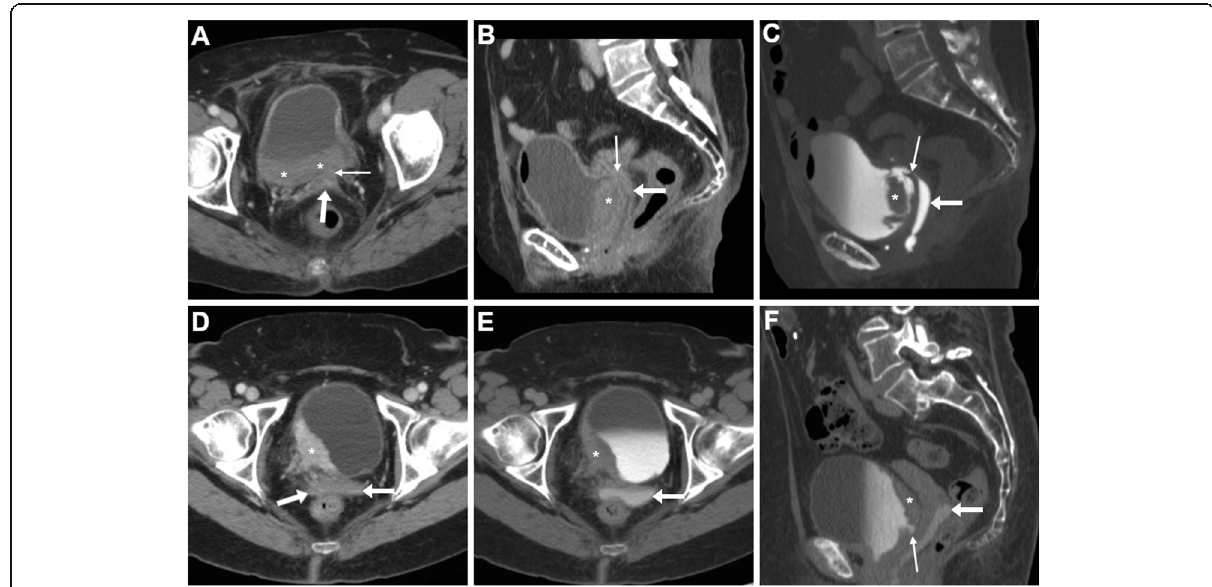
Fig. 16 Two cases of urinary VF complicating bladder cancers. a – c In a patient with previous hysterectomy, CT ( a , b ) shows extensive mural thickening (*) of the posterior bladder aspect, causing adhesion and focal retraction of the bladder dome, and corresponding filling defect on excretory phase acquisition ( c ). The patent VF (thin arrows) leads to opacification of the vagina (arrows). d – f In a patient with strongly enhancing tumour (*) of the right posterolateral aspect of urinary bladder ( d ), excretory phase acquisition ( e , f ) shows vaginal opacification (arrows) via a short VF (thin arrow in f )